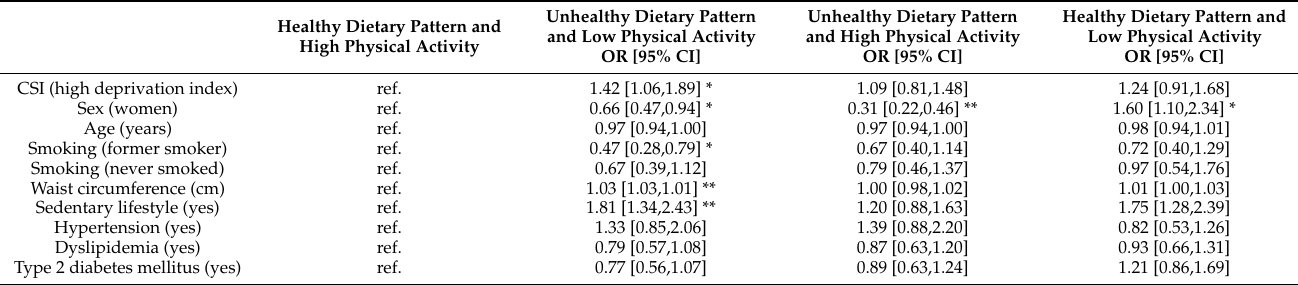
Table 4. Relationship between CSI categories and lifestyle (dietary patterns + physical activity). Healthy Dietary Pattern and High Physical